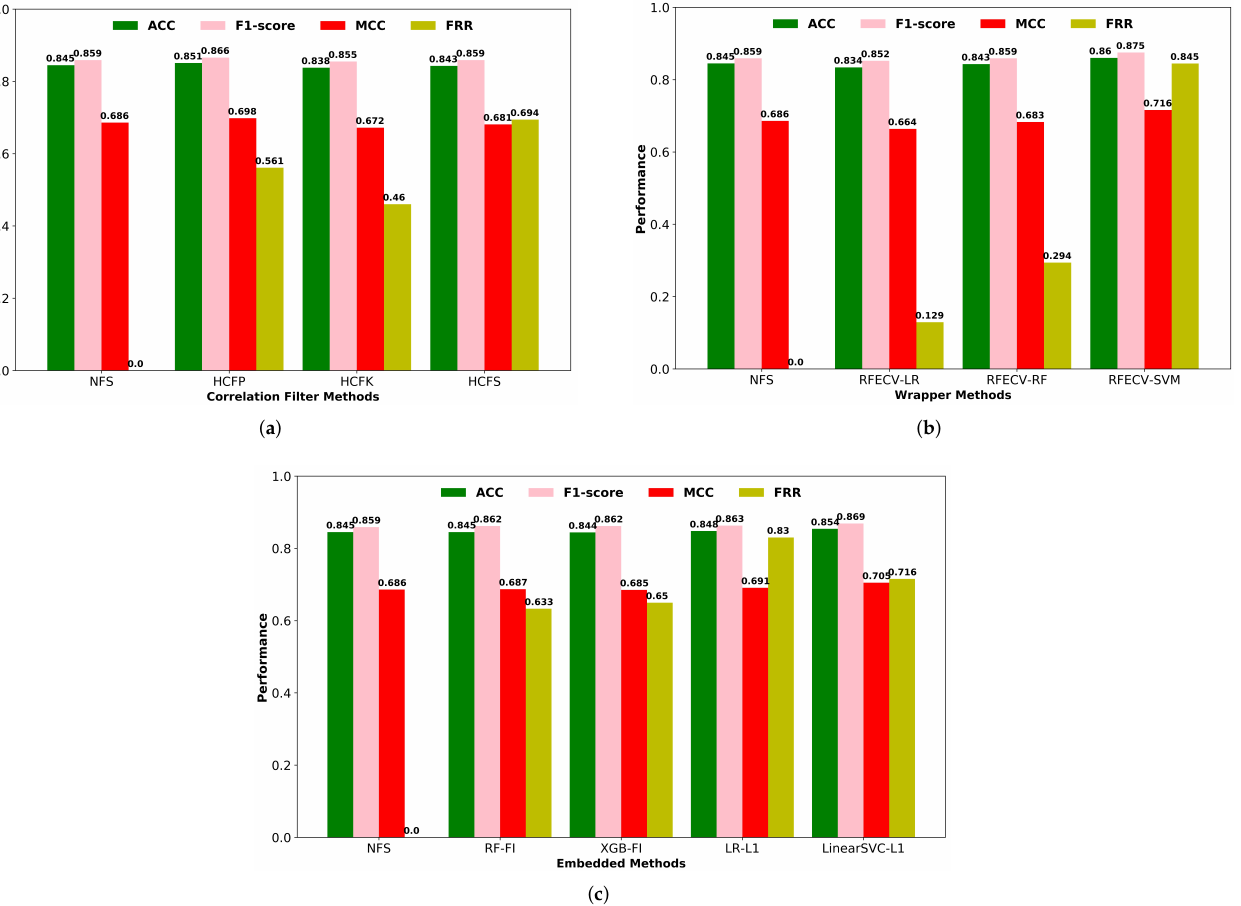
Figure 3. ( a ) Performance of correlation filters based feature selection methods. NFS: No feature selection; HCFP: High correlation filtering using Pearson’s correlation coefficient; HCFK: High correlation filtering using Kendall’s rank correlation coefficient; HCFS: High correlation filtering using Spearman’s rank correlation coefficient. ( b ) Wrapper methods. ( c ) Embedded Methods. NFS: No feature selection; RF-FI: Random Forest Classifier based feature importance; XGB-FI: XGB Classifier based feature importance; LR-L1: Logistic regression with L1-based feature selection; Linear SVC-L1: Linear SVC with L1-based feature